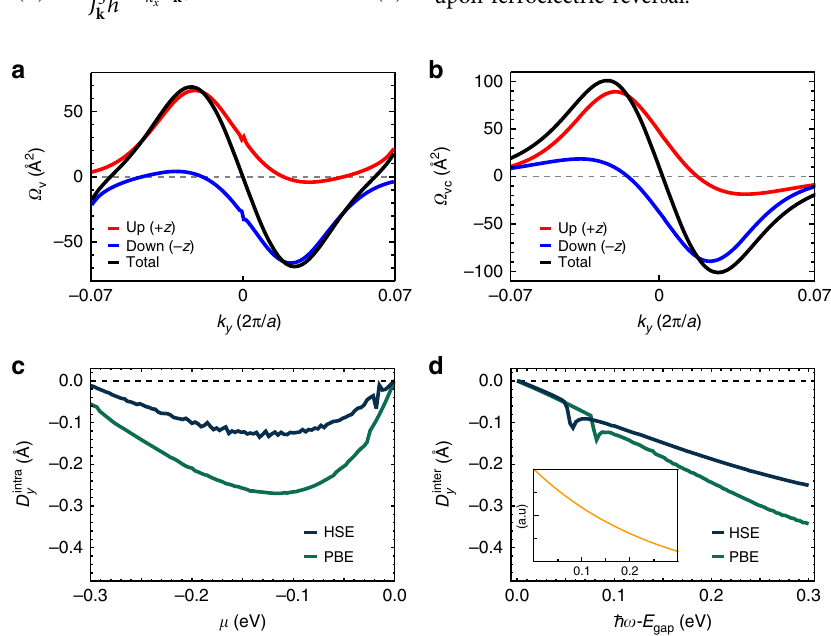
Fig. 4 Berry curvature and Berry curvature dipoles. a The calculated Berry curvatures (BCs) for the highest valence bands near the X valley. The spinup (spindown) component is represented by a red (blue) line. b The calculated inter-band BCs between the highest valence bands and the lowest conduction bands near the X valley. The spinup (spindown) component is represented by a red (blue) line. c The intraband BC dipole as a function of the Fermi level and d the interband BC dipole as a function of the photon frequency, which were calculated from the PBE and HSE functionals. The inset shows the interband BC dipole calculated from our analytic formalism, Eq. (6), in which the unit of the horizontal axis is the same as the numerical result and the vertical axis of the interband BC dipole is presented in arbitrary